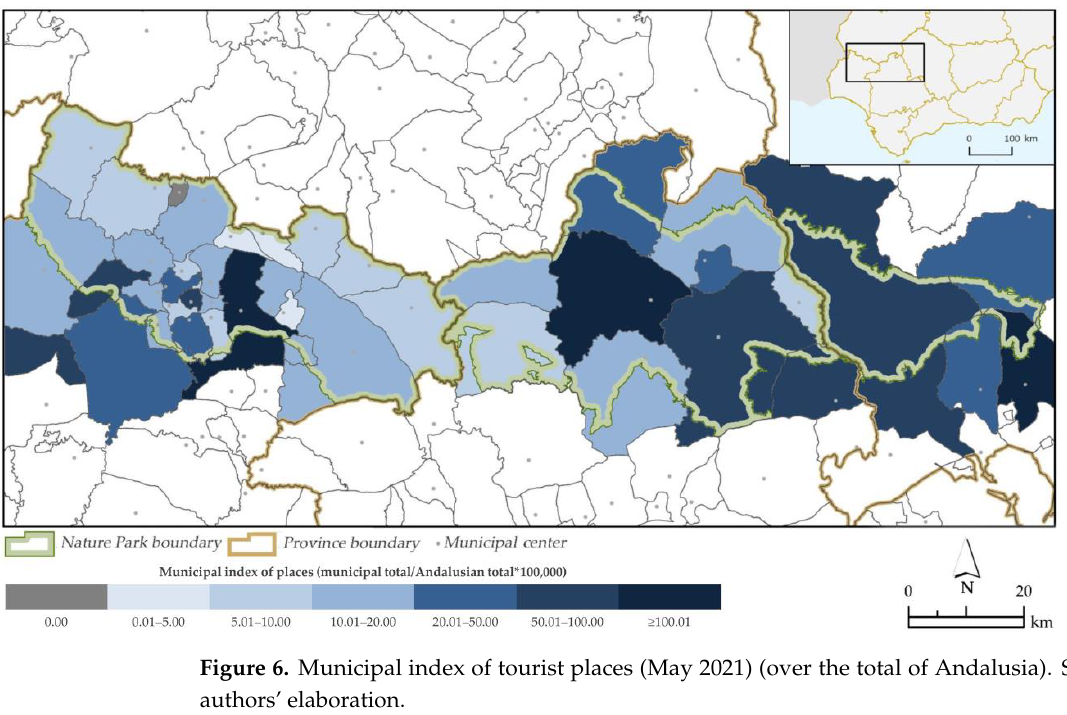
Figure 6. Municipal index of tourist places (May 2021) (over the total of Andalusia). Source: [85]; authors’ elaboration.